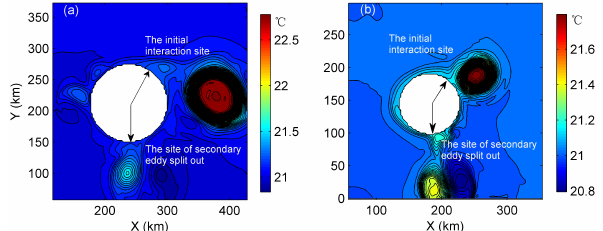
Figure 10. Comparison of the interactions between different sized islands and eddies (a) the island diameter is 120km and the eddy diameter is 90km; (b) the island diameter is 90km and the eddy diameter is 60km. The colours represent the temperature at 100m depth and the black arrows indicate the initial eddy–island interac- tion site and the site of secondary eddy